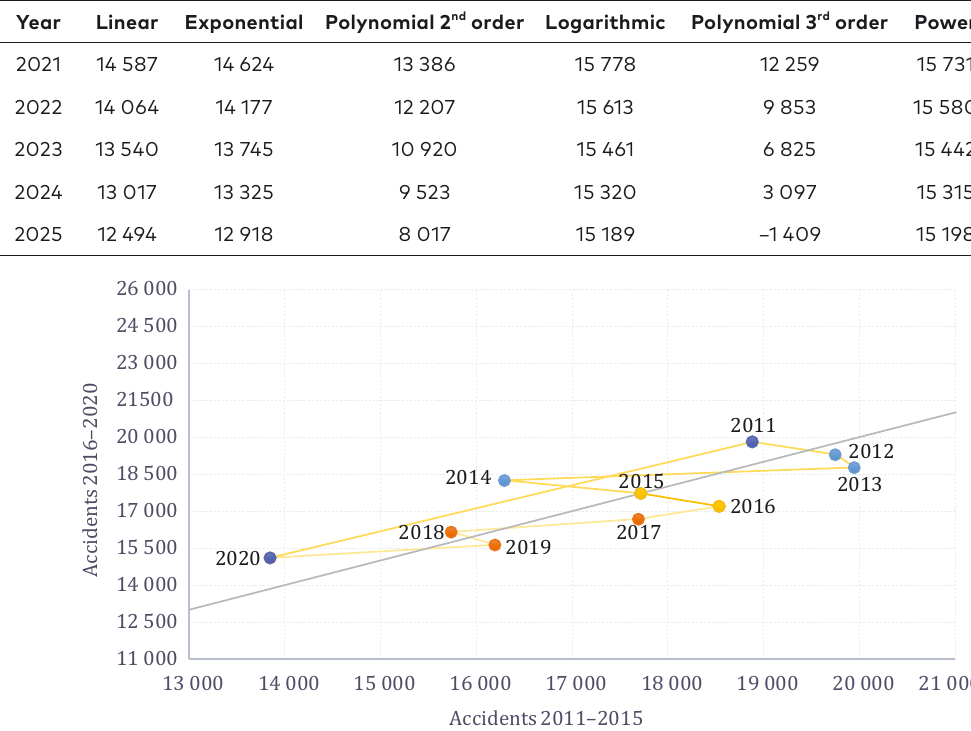
Figure 10. IPTA diagram of the linear trend